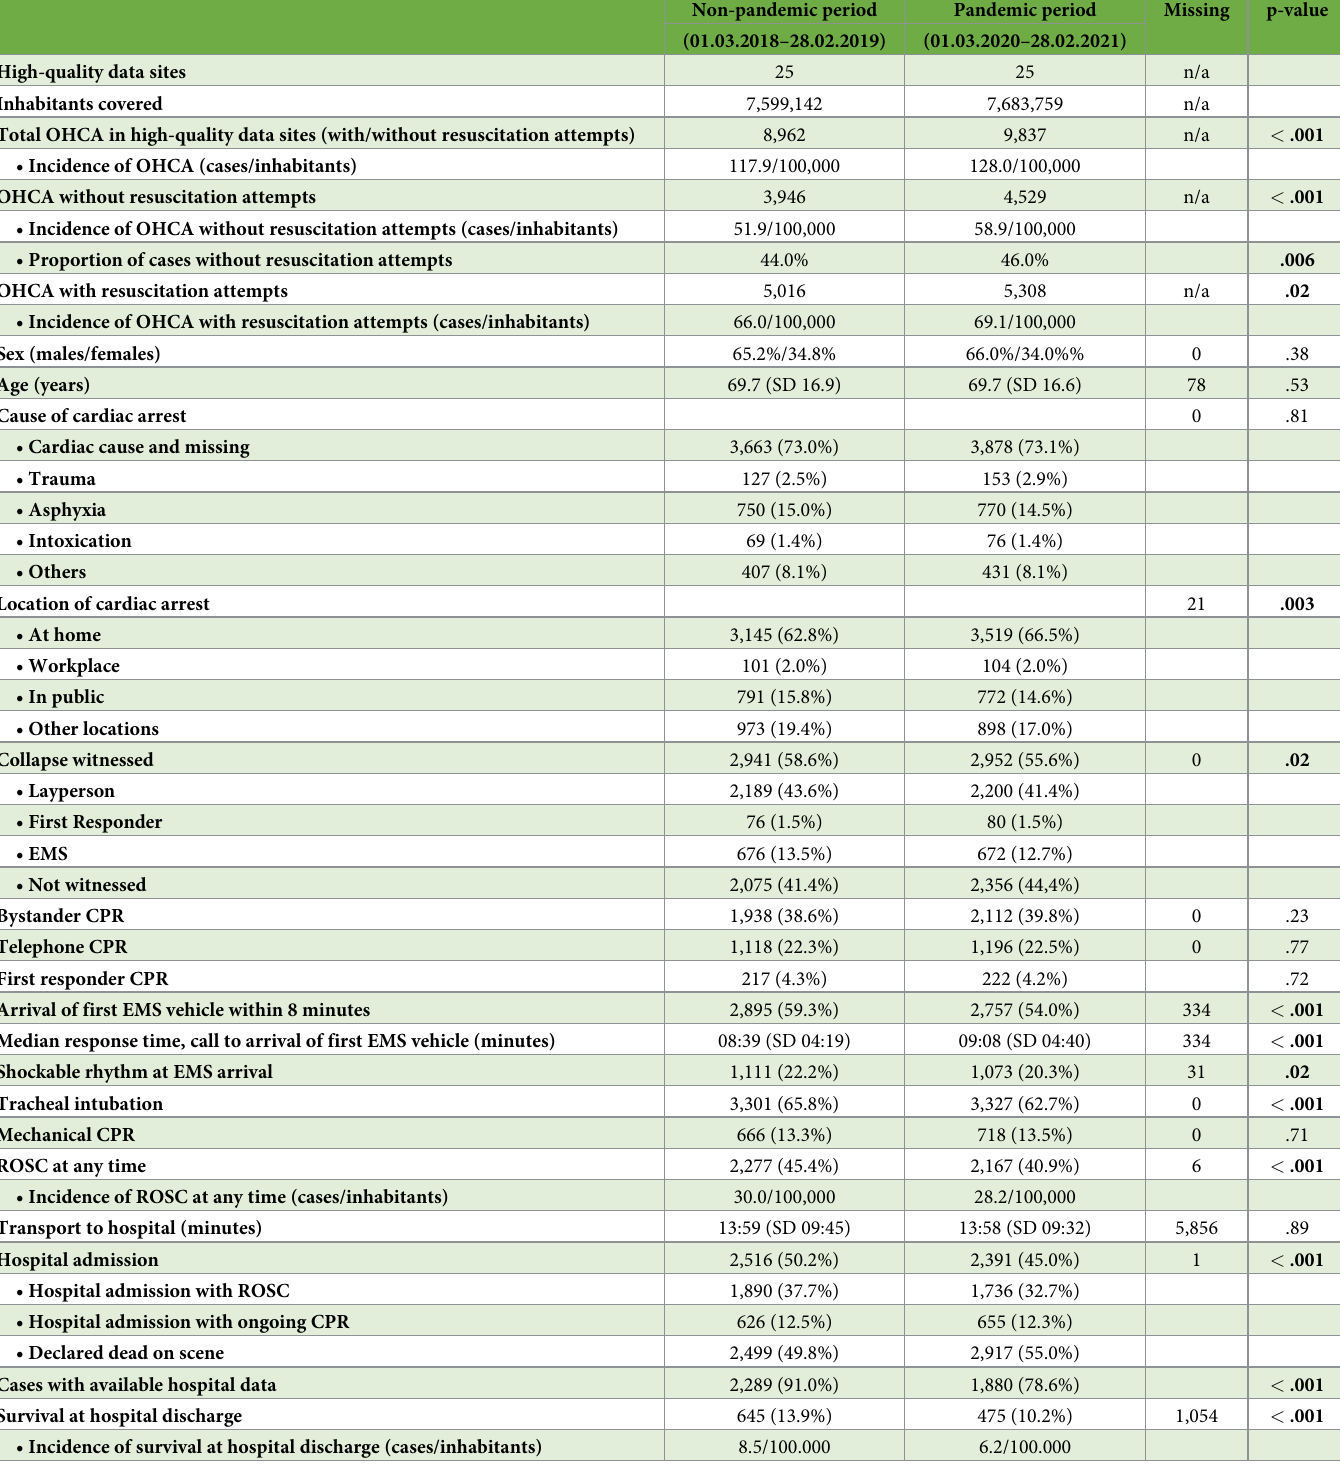
Table 1. Baseline characteristics, initial management, and outcome of